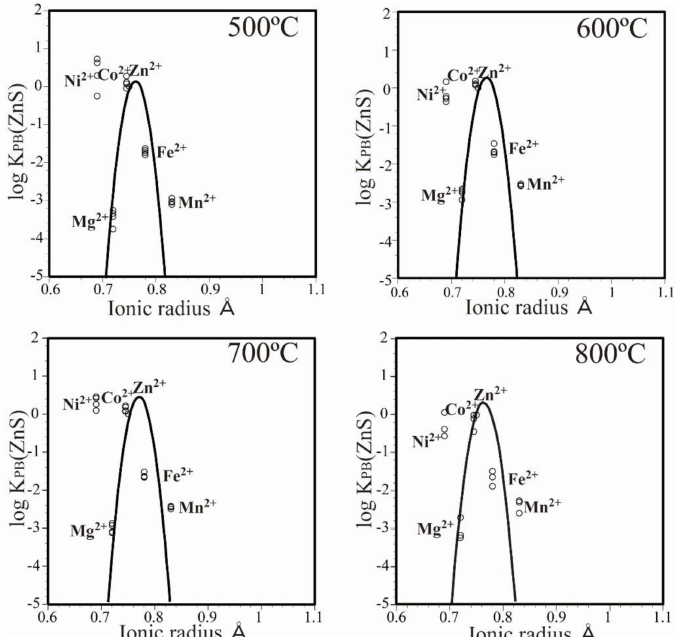
Figure 4. Logarithmic value of bulk partition coefficient (log K PB (ZnS)) vs. ionic radius (PC–IR) diagrams for the ZnS–(Ni, Mg, Co, Fe, Mn)Cl 2 –H 2 O system. PC–IR curves drawn with a quadratic equation and assuming that Mg, Co, Zn, Fe, and Mn will show partition behavior according to their ionic radii.